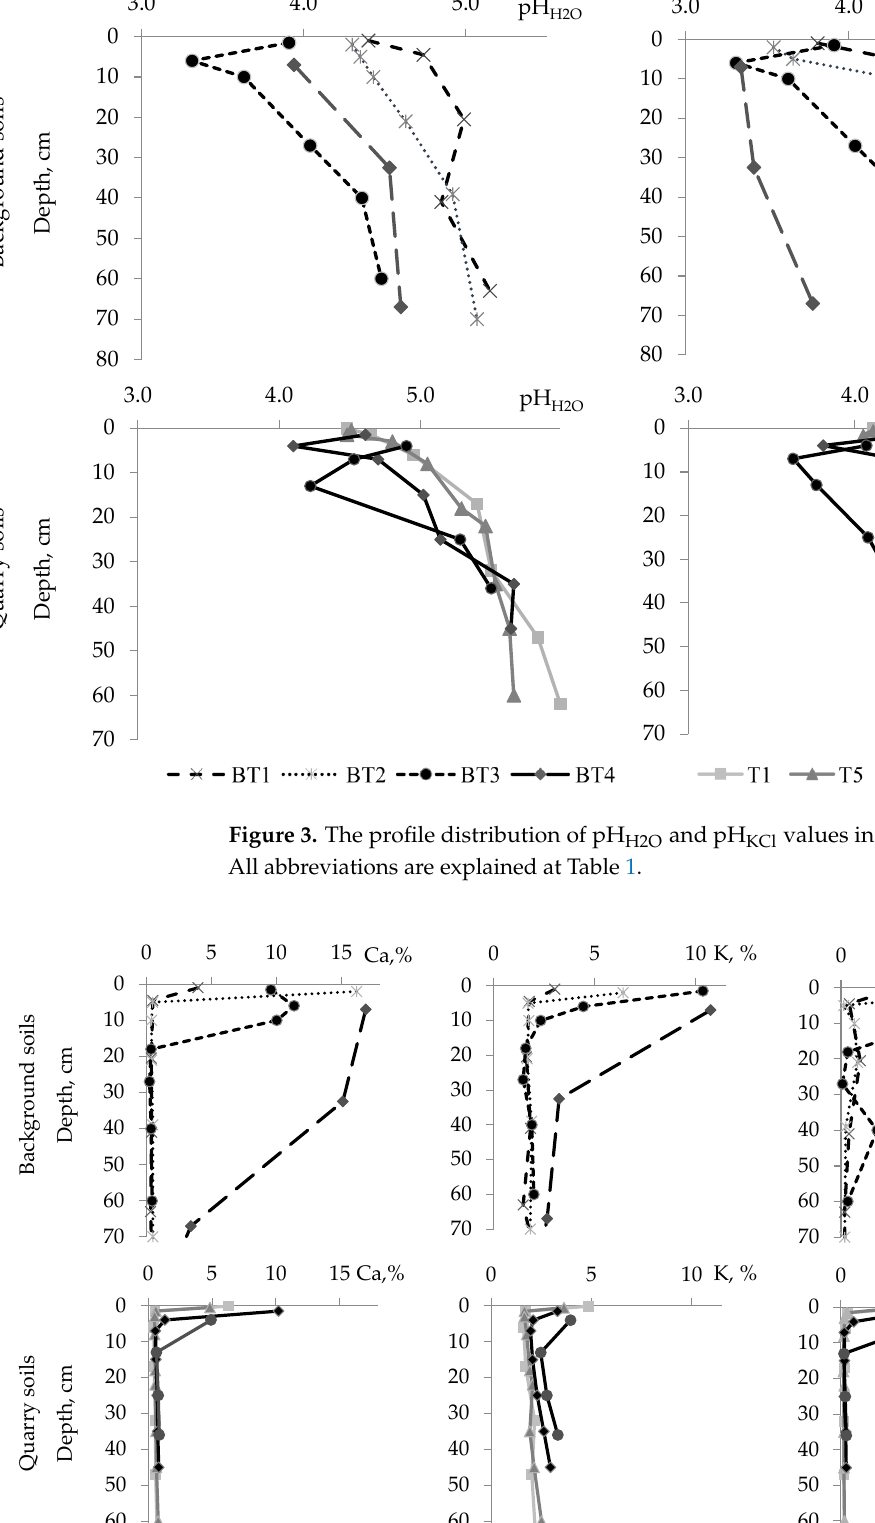
Figure 4. The profile distribution of total content of biogenic elements Ca, K, and P in the background and quarry soils. All abbreviations are explained at Table